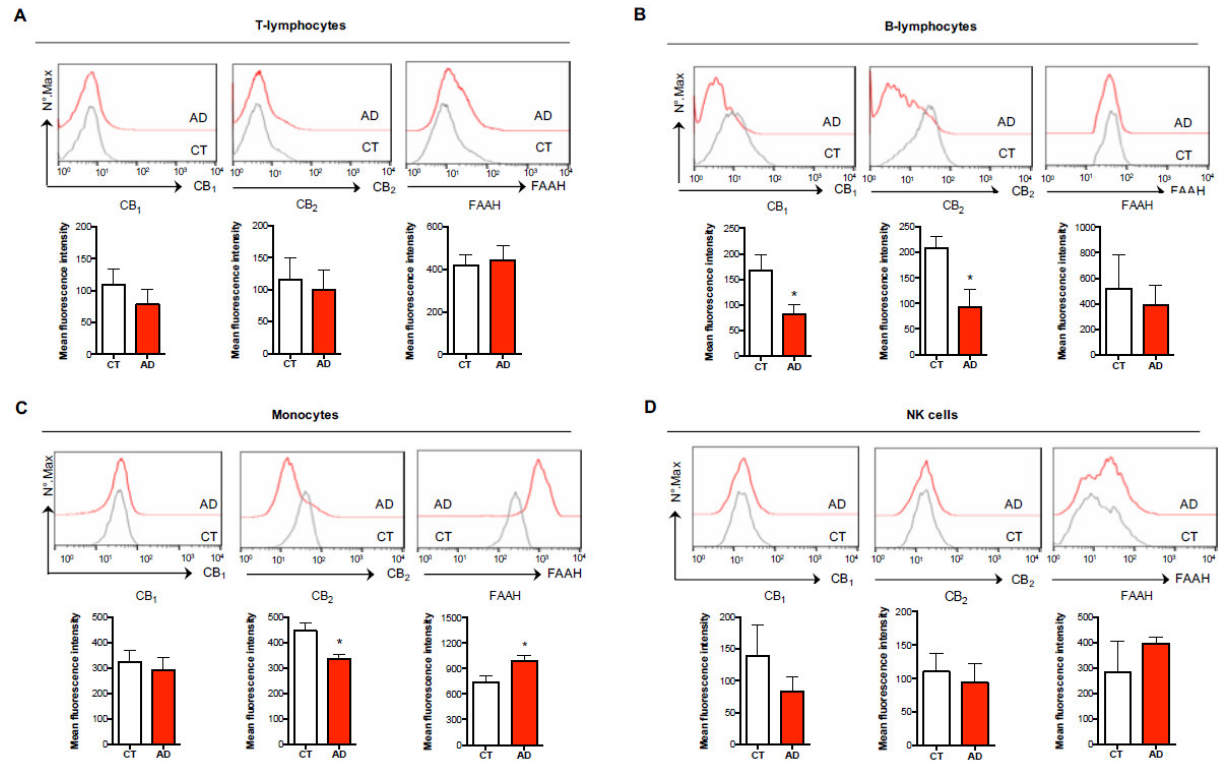
Figure 2. Characterization of endocannabinoid (eCB) system elements in different immune cell subsets of healthy controls and AD subjects. Surface expression of type-1 and type-2 cannabinoid receptors (CB 1 , CB 2 ) and intracellular expression of fatty acid amide hydrolase (FAAH) in human T-lymphocytes (CD3+) ( A ), B-lymphocytes (CD19+) ( B ), monocytes (CD14+) ( C ), and NK cells (CD56+) ( D ) of healthy controls (CT) and AD subjects was assessed through polychromatic flow cytometry as detailed in the materials and methods. The histograms represent the mean intensity fluorescence (MIF) ± s.e.m. of 7–9 independent experiments. * p < 0.05 vs. CT.